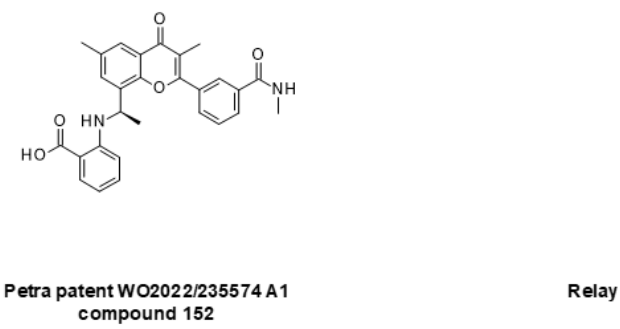
Figure 9. Mutant-selective allosteric inhibitors of PI3Kα.